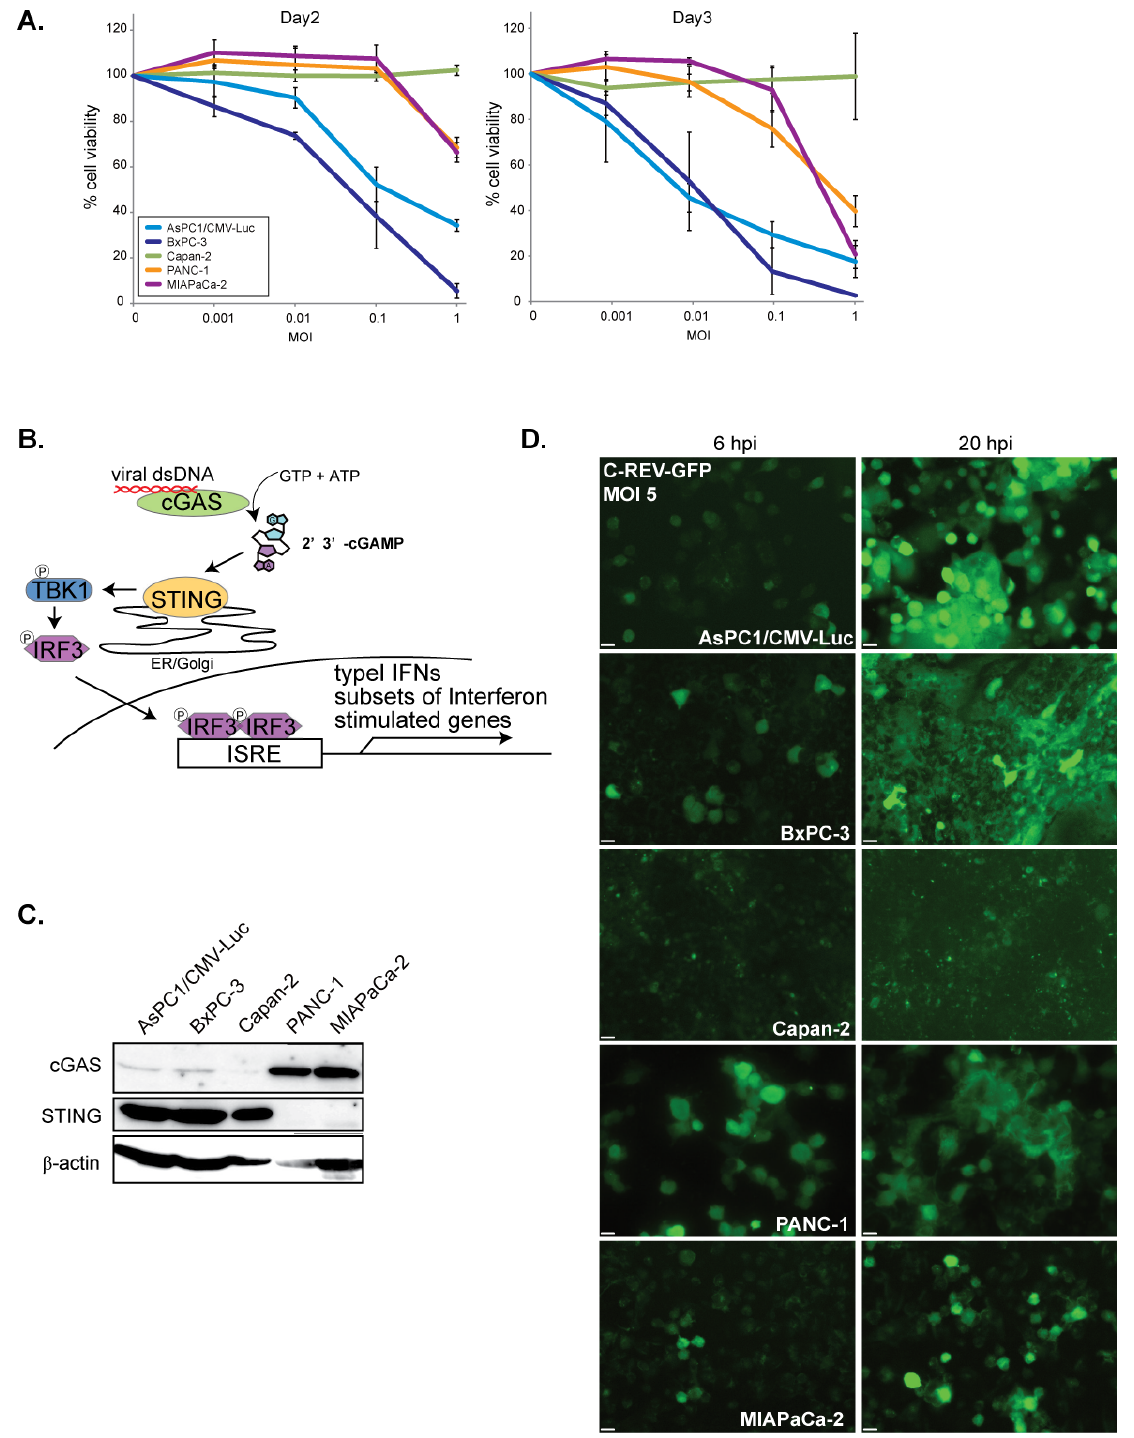
Figure 1. Susceptibility to C-REV on human pancreatic cancer cell lines. ( A ) Cytotoxicity of C-REV with several MOI against the indicated human pancreatic cancer cell lines on day 2 and day 3 by MTT assay. Data are presented as mean ± SEM of 3 independent experiments. ( B ) A brief illustration of the STING pathway. ( C ) Western blot analysis on STING and cGAS. ( D ) Images of the indicated cells infected with C-REV-GFP (MOI 5) at 6 hpi or 20 hpi. Scale bar represents 20 μ m.